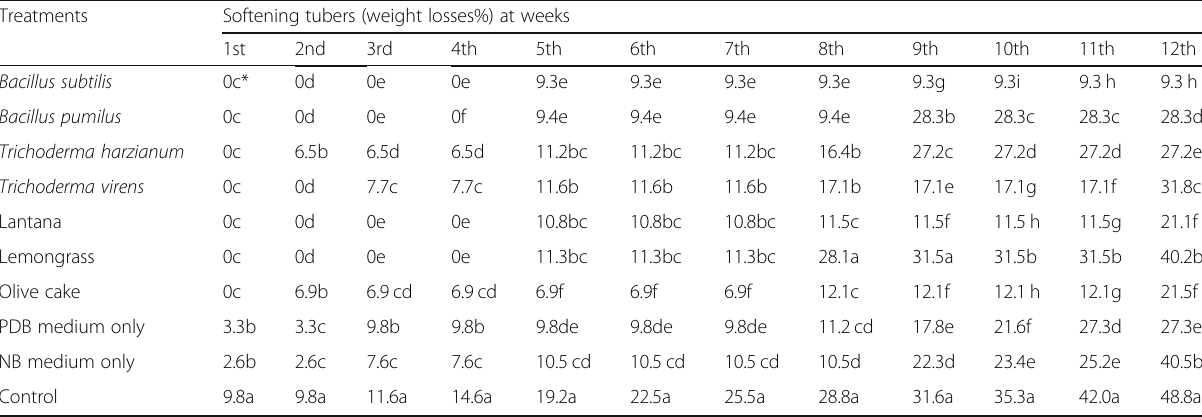
Table 4 Effect of bio-control agents and aqueous plant extracts as soil treatment against bacterial soften potato tubers disease (as weight losses %) under storage conditions Treatments